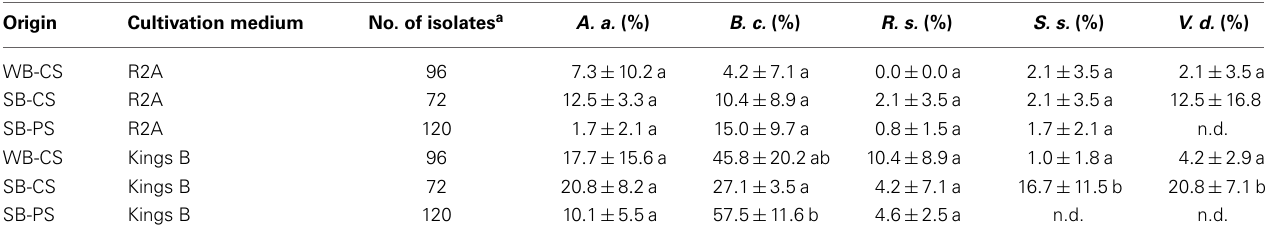
Table 3 | Antagonistic potential toward various plant